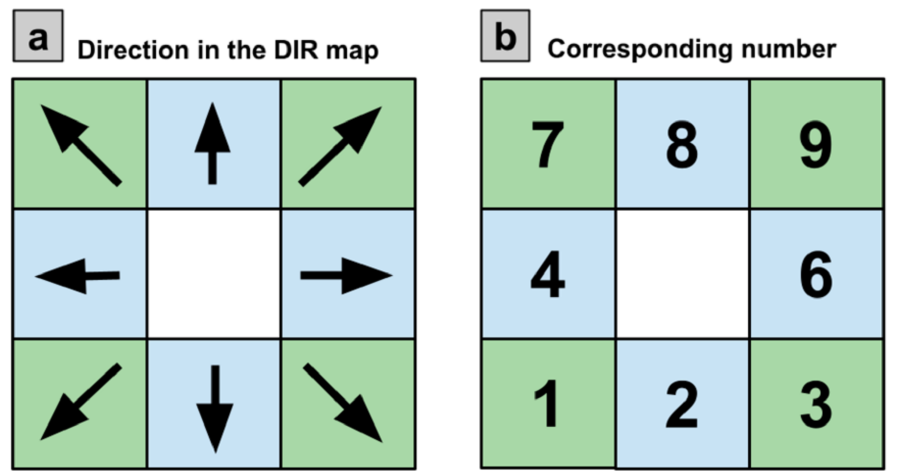
Figure 2. Flow direction map (DIR) numbering conventions for WMF. The panels show the flow’s physical direction ( a ) and the corresponding number ( b ). Blue and green colors represent orthogonal and diagonal flows,